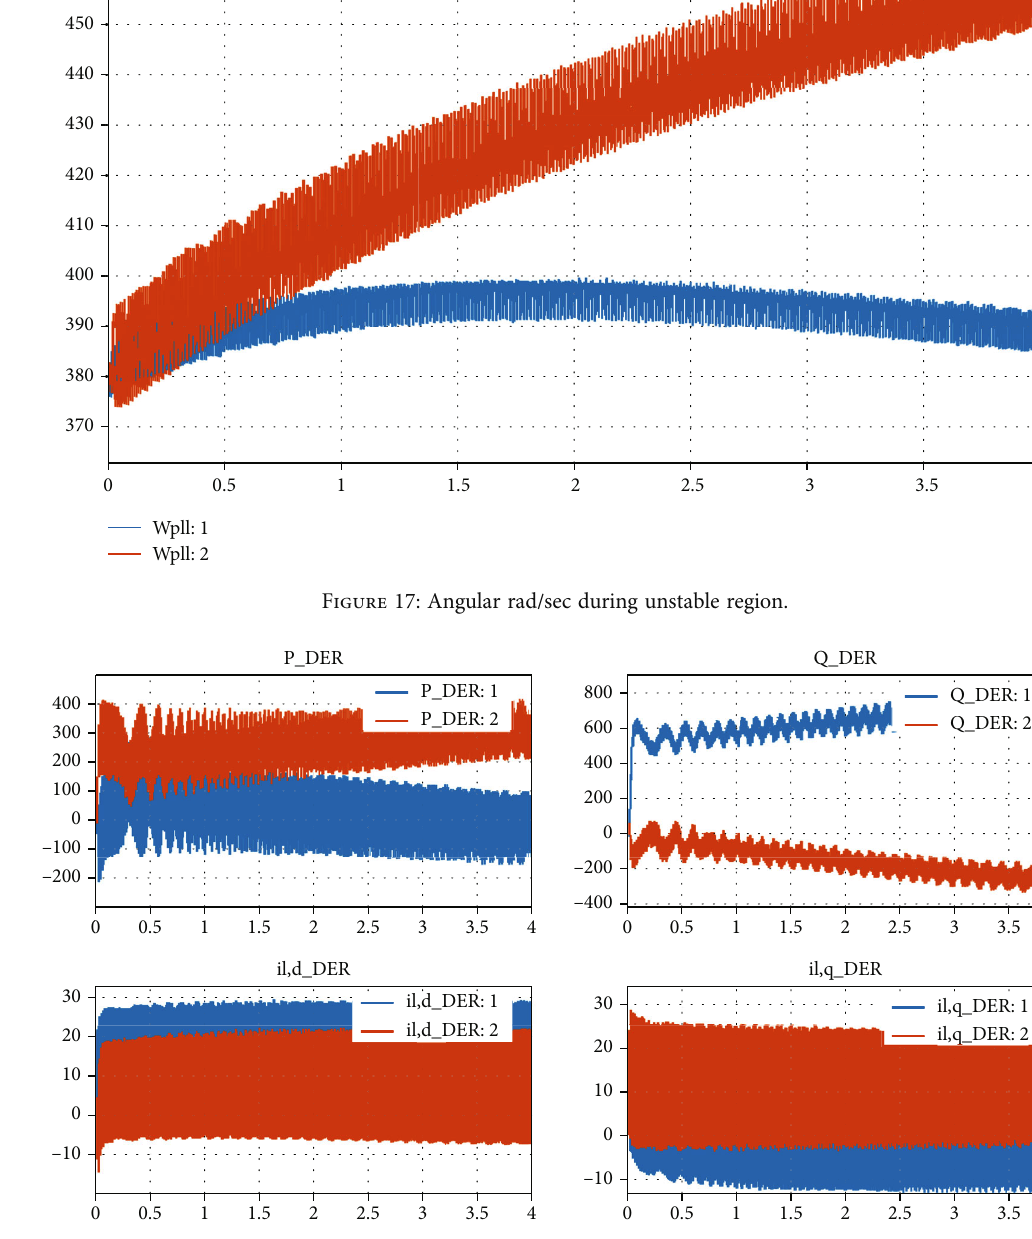
Figure 18: Real and reactive powers are unstable